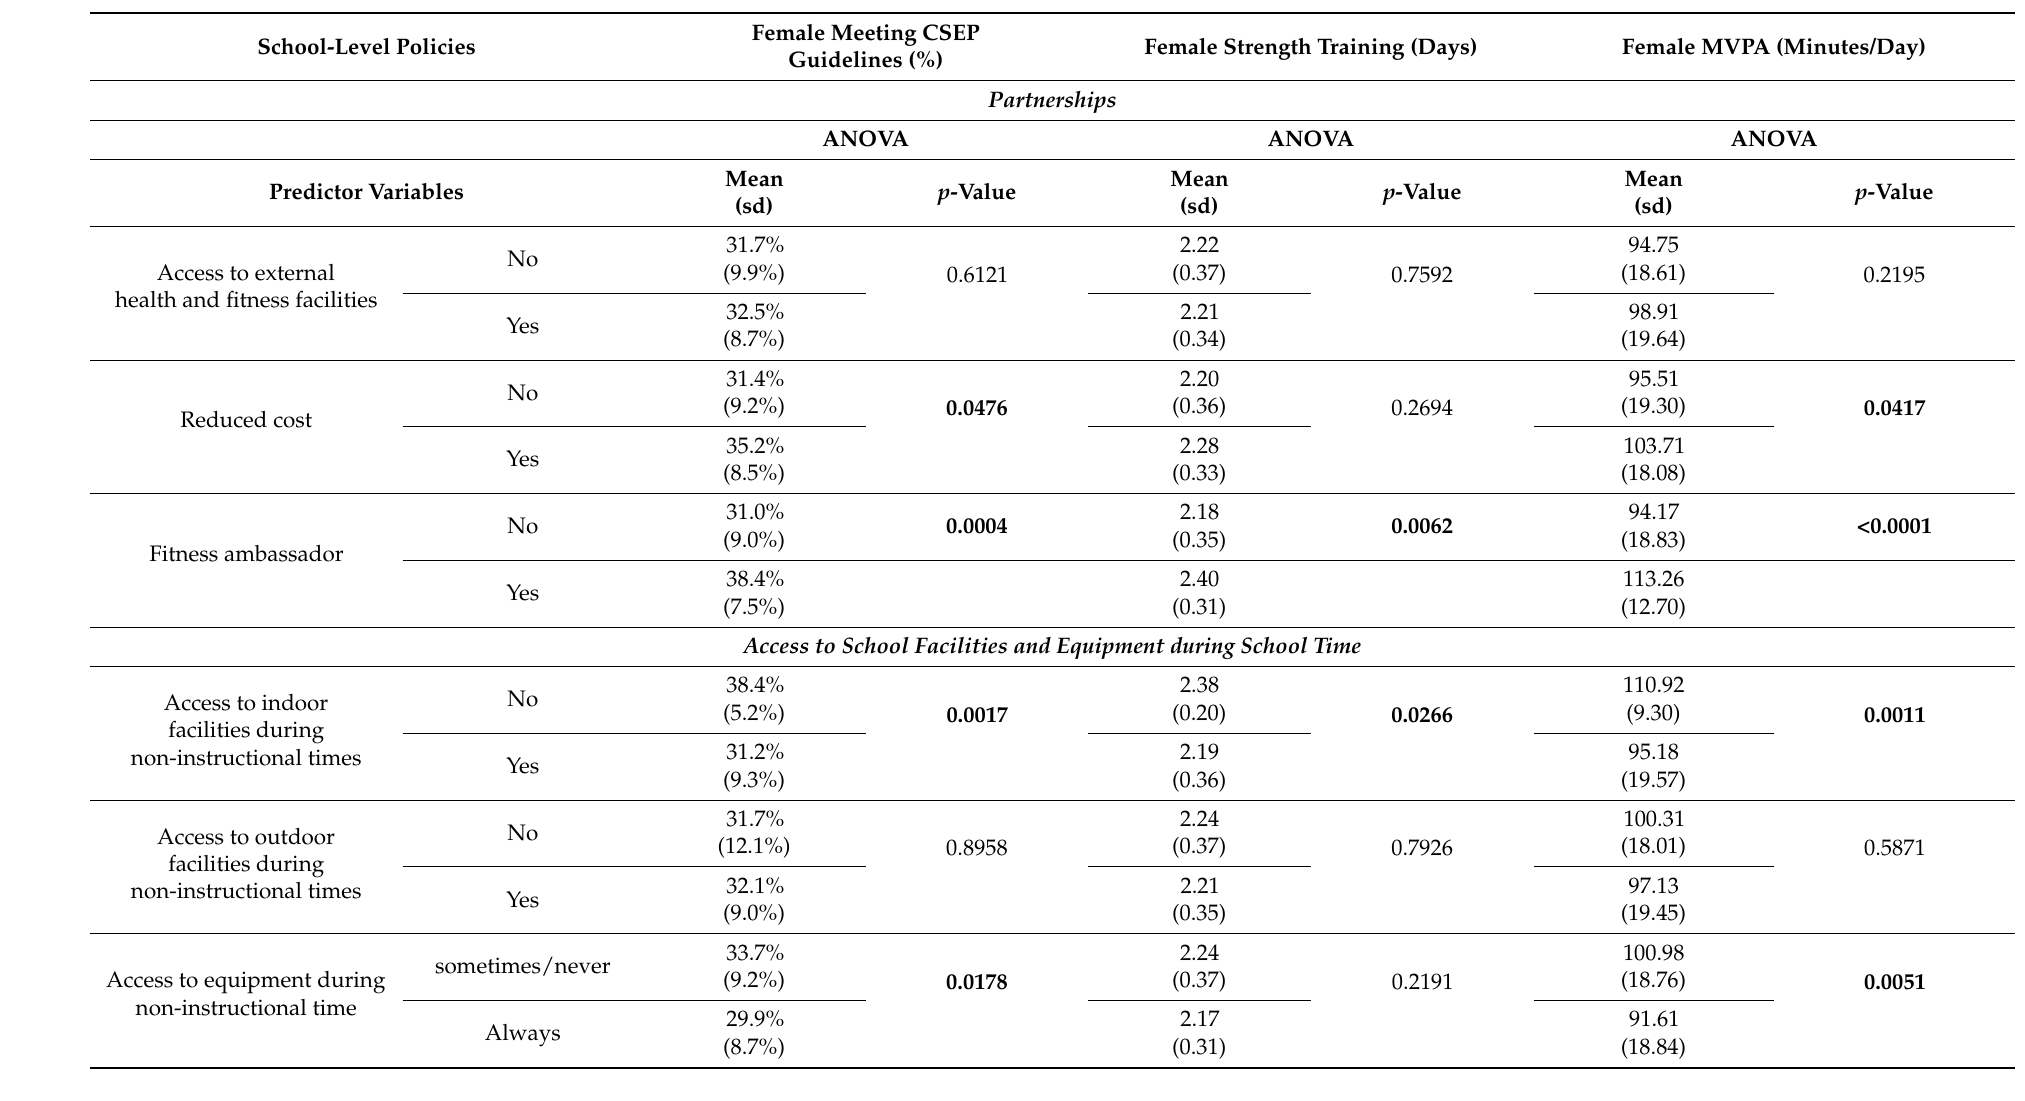
Table 3. Associations between School-Level Policies and Physical Activity Outcomes among Female Students from Year 7 (2018–2019) of the COMPASS